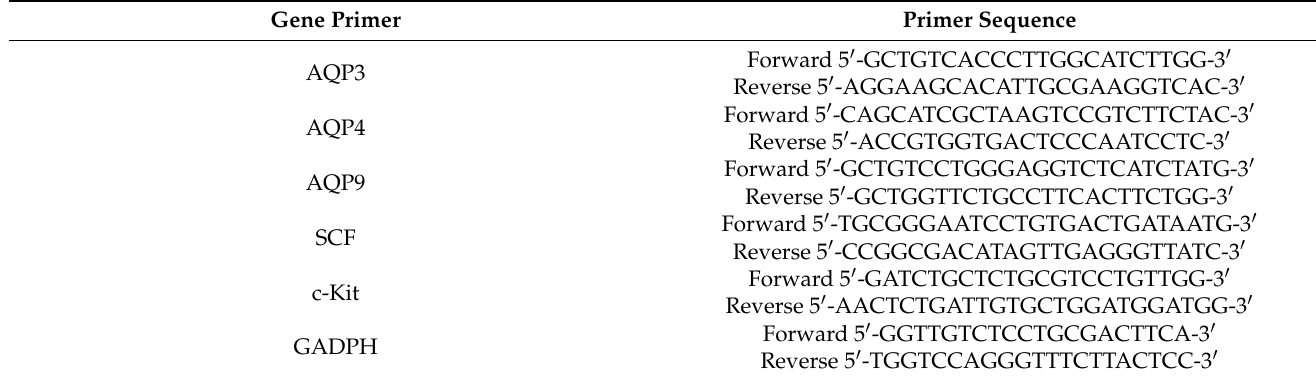
Table 2. Gene Primer of water channel proteins (AQP3, AQP4, and AQP9), c-Kit, SCF and GADPH. Gene Primer Primer